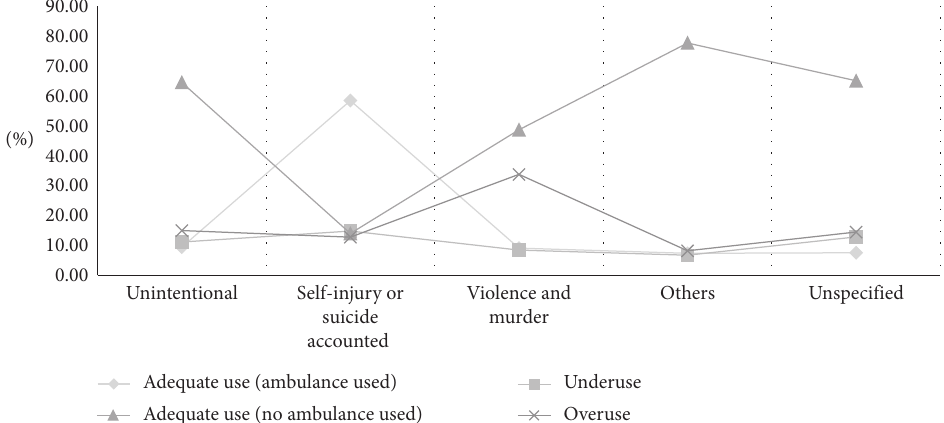
Figure 3: Comparison by the intention of injury. In the group of violence, overuse is more and there was a higher rate of appropriate use due to